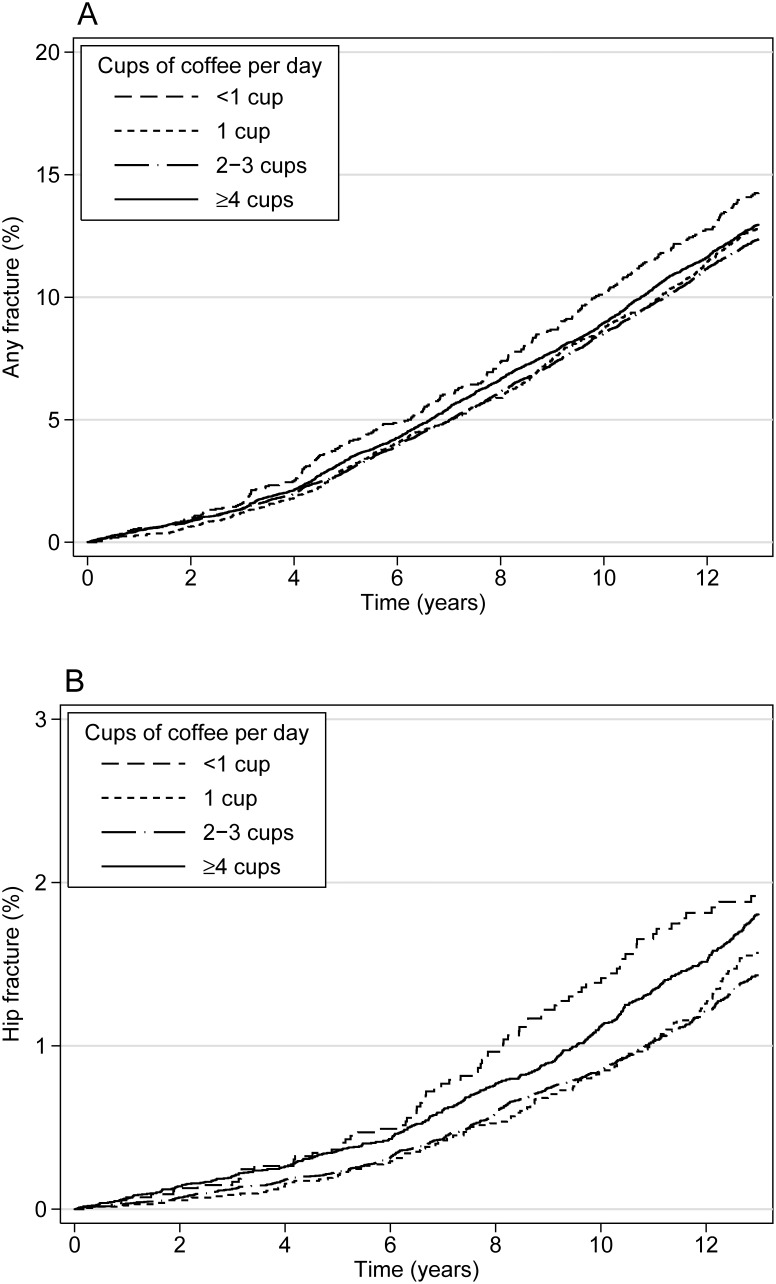
Fracture incidence in the Cohort of Swedish Men (COSM).Incidences of any fracture (Panel A) and hip fracture (Panel B) in relation to follow-up using Kaplan-Meier failure curves adjusted to age 60 for the four consumption categories of coffee (<1, 1, 2–3 and 4 cups or more per day).